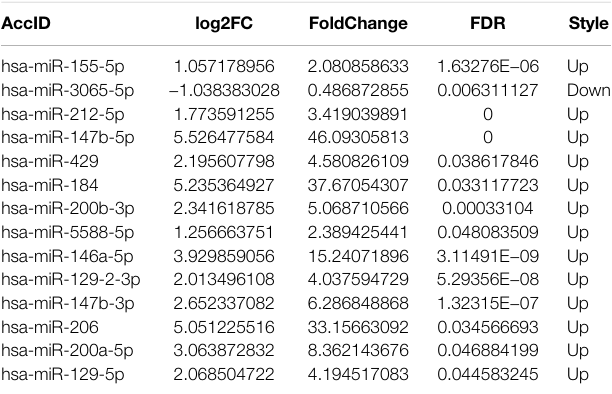
TABLE 1 | Fourteen differentially expressed miRNAs (OA menisci with vs. without IL-1 β treatment;log 2 FC < 1, FDR < 0.05). AccID log2FC FoldChange